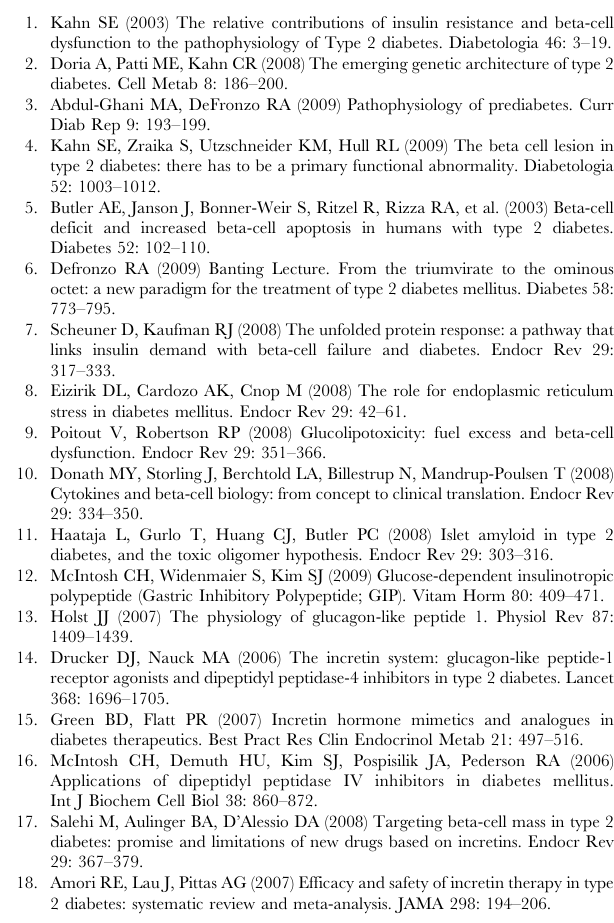
Figure S2 D-GIP 1–30 treatment reduces weight gain in VDF rats. Bodyweights of VDF rats treated as described in Figure 3 were monitored every 2 days. Absolute body weights before and after (day 0 and 10) are shown in A and relative increases in body weight from day 0 are shown in B. Mean 6 SEM (n= 6); *, p , 0.05 vs VDF rats treated with PBS. Figure S3 Representative sections of pancreases collected from Lean and obese ZDF treated with PBS or D-GIP 1–30 . Insulin positive (beta-cell) area were stained via peroxidase catalyzed reaction with 3,3 9 -Diaminobenzidine. Found at: doi:10.1371/journal.pone.0009590.s003 (0.44 MB